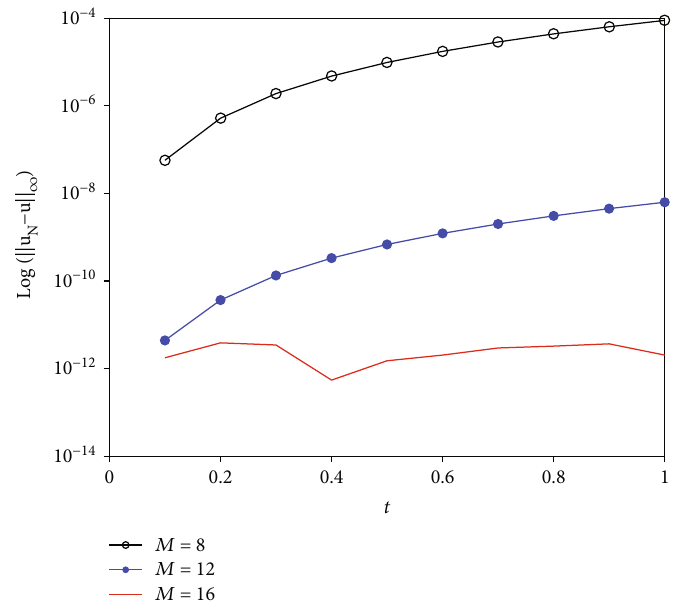
Figure 4: The maximum absolute error with di ff erent M and N = 16